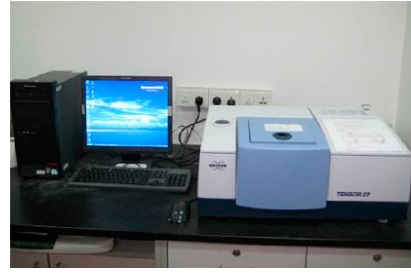
Figure 5. FTIR spectrometer.